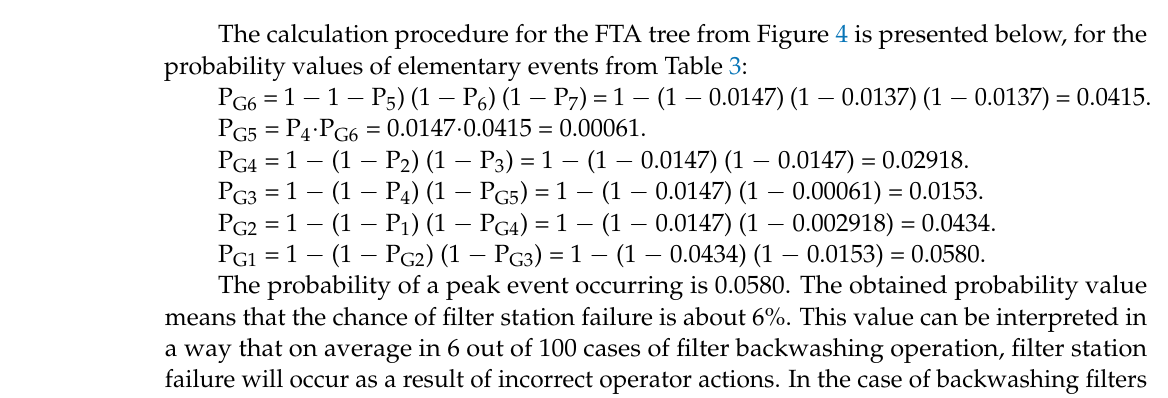
Table 3. The probability of elementary events.